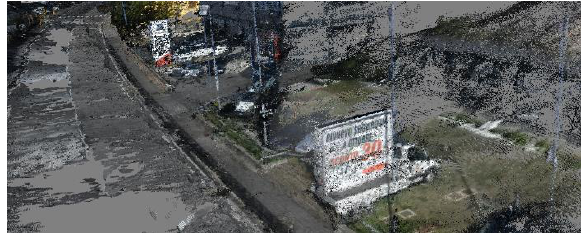
Figure 7. Some sample of advertising panels visible in the point cloud